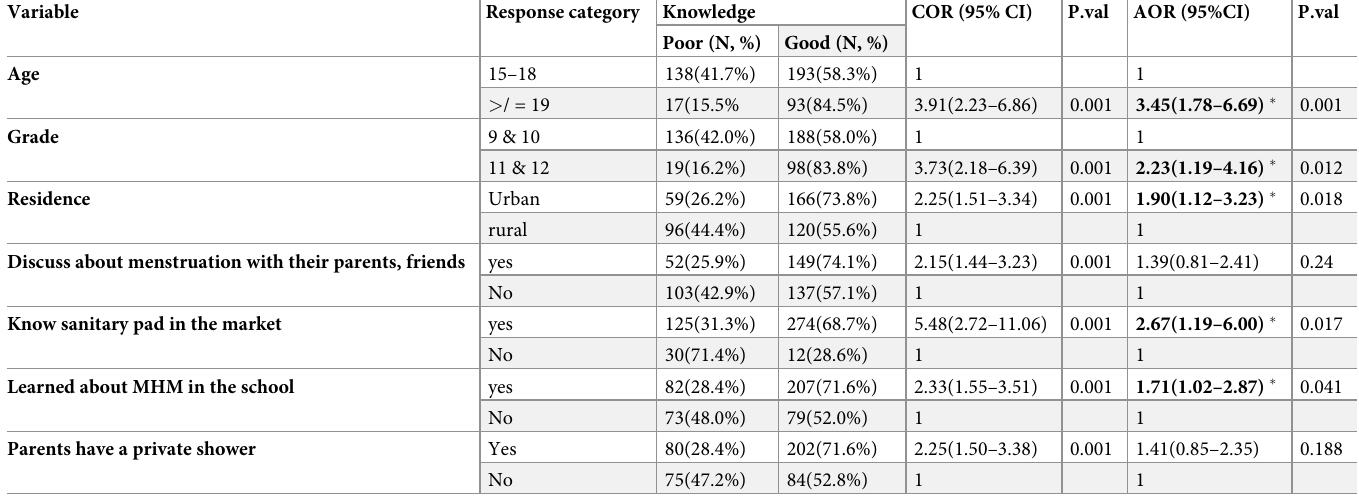
Table 3. Factors independently associated with knowledge on menstrual hygiene management of Mekdela secondary school girl students, Amhara region, Northeast Ethiopia